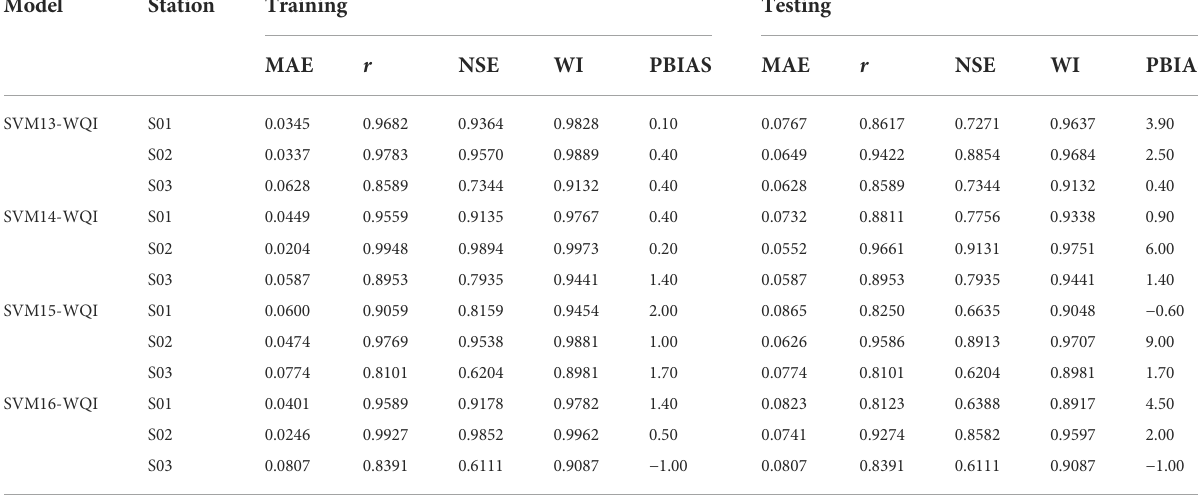
TABLE 10 Performance evaluations for the fourth